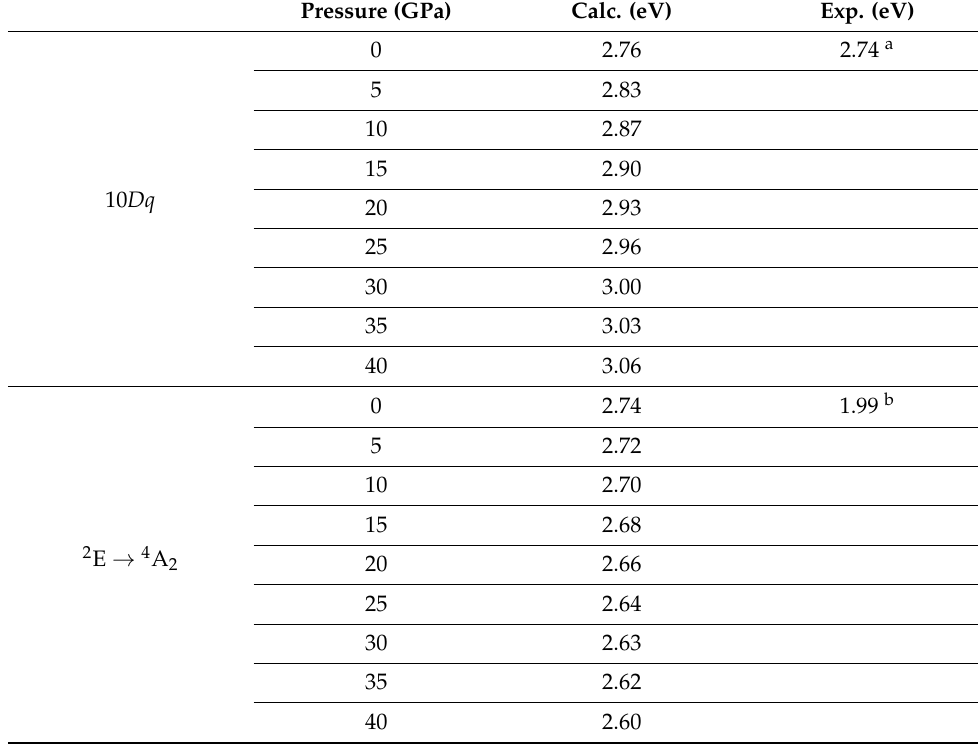
Figure 7. Calculated emission energy, E em , and 10 Dq for Mn 4+ -doped K 2 SiF 6 as a function of pressure. The solid lines are the least-square linear fittings.